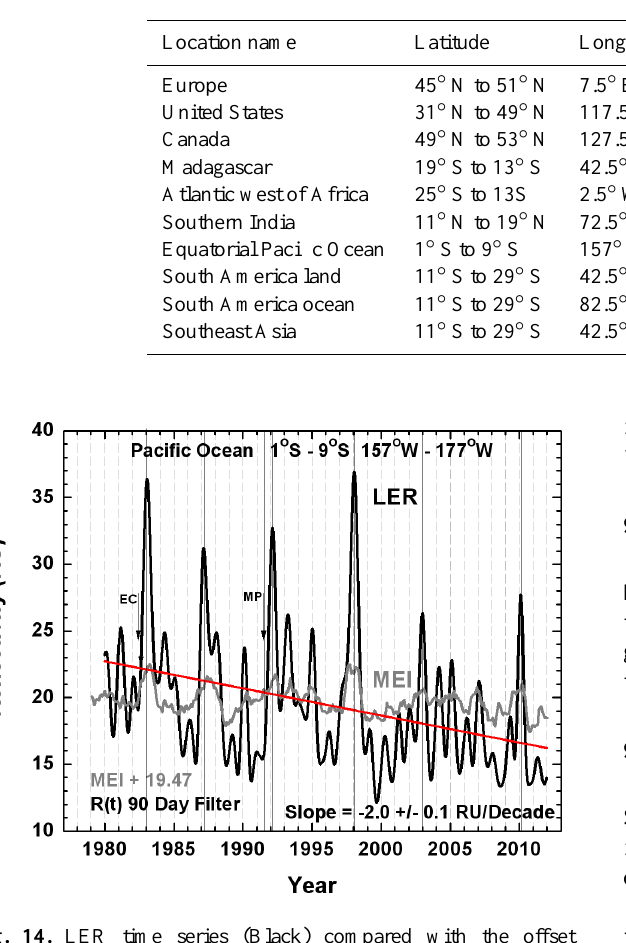
Table 2. LER Trends at locations in Fig. 17.